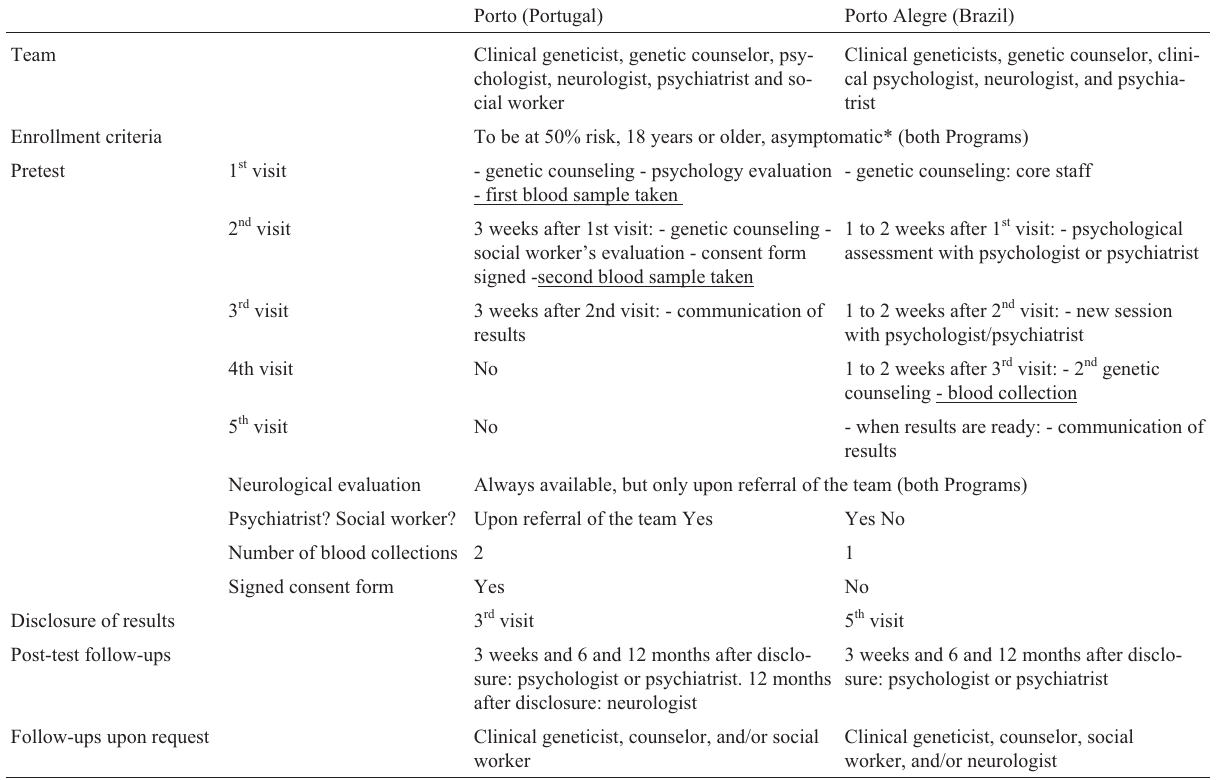
Table 1 - Similarities and differences between the Portuguese and Brazilian programs for genetic counseling and presymptomatic